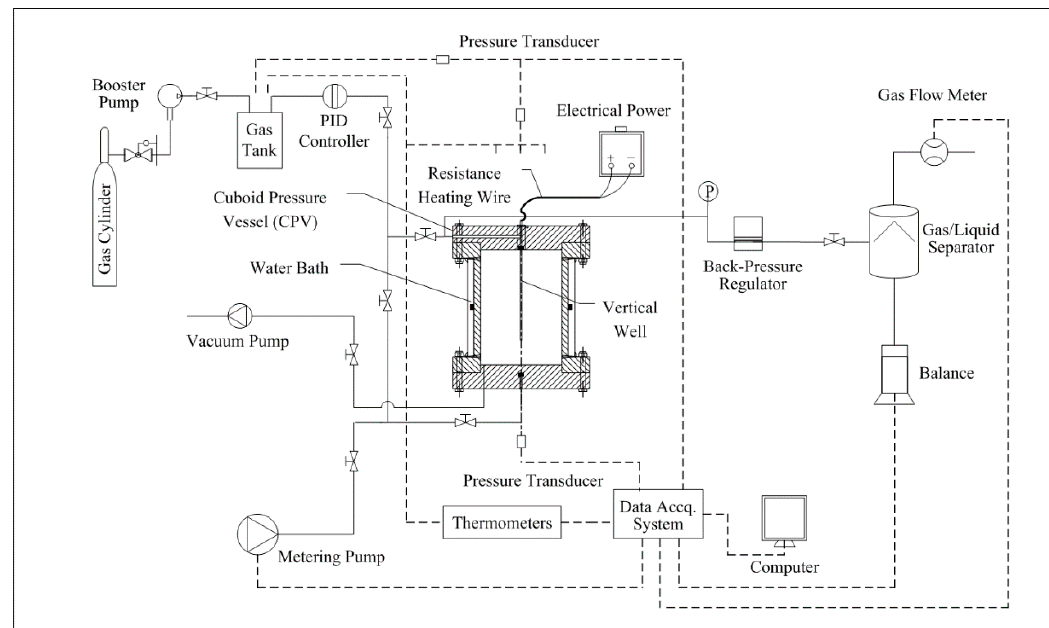
Figure 1. Schematic of the experimental system.